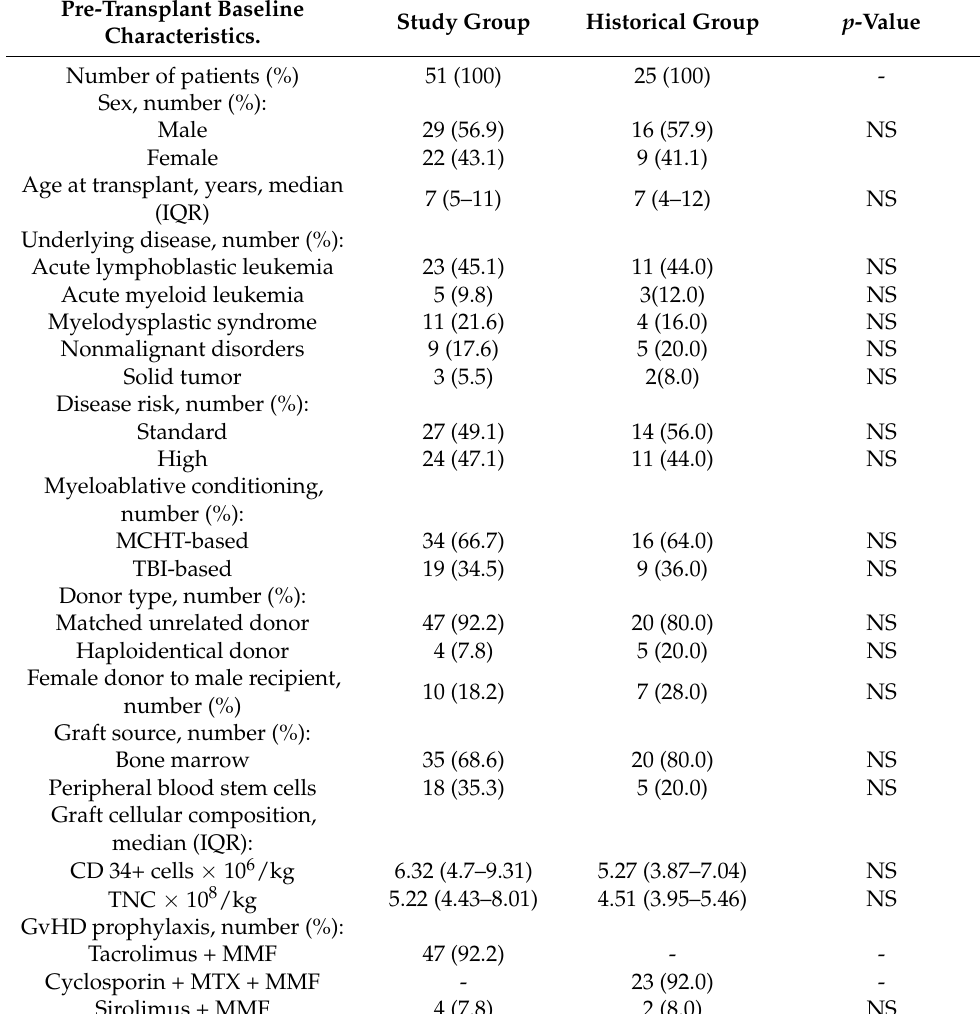
Table 1. Patient demographics, clinical, and HSCT